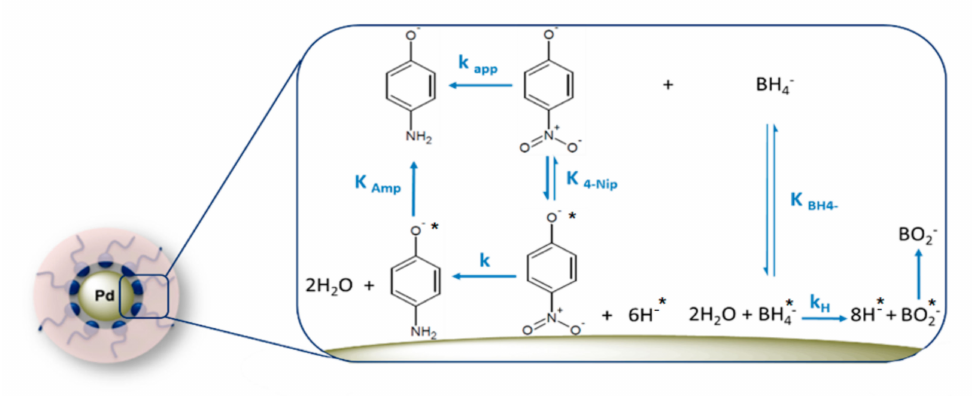
Figure 1. Schematic representation of the Langmuir–Hinshelwood mechanism of 4-Nip reduction on the surface of Pd